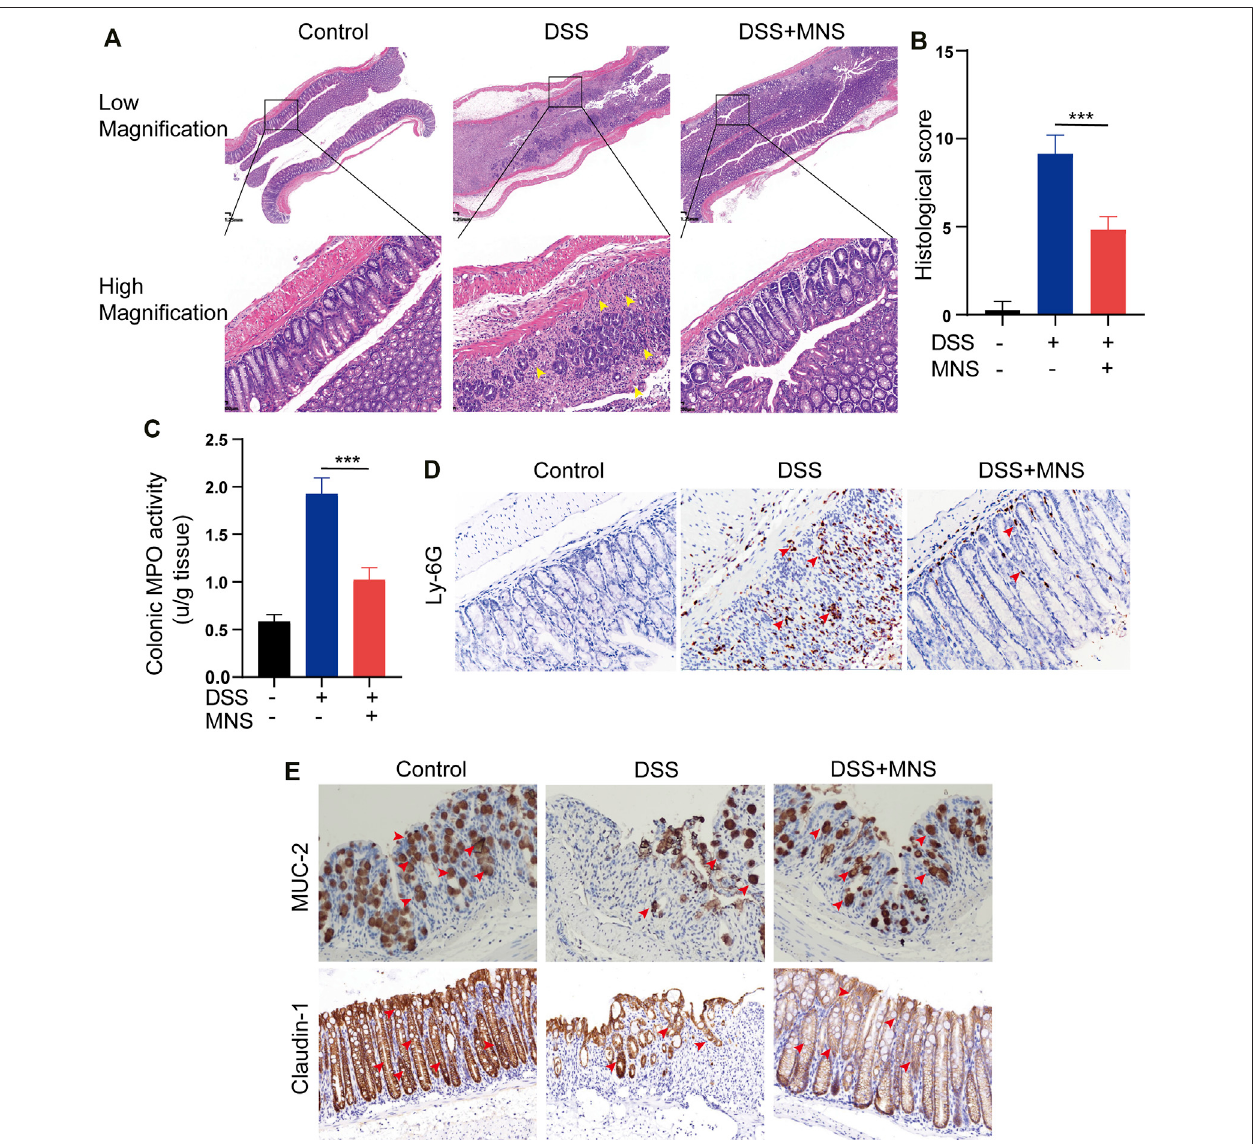
FIGURE 4 | MNS reduced histopathological damage during DSS-induced colitis. (A) Hematoxylin and eosin stain of colon tissue, epithelium loss, and crypt structure collapse were marked with yellow arrows. (B) Histological scores of blinded sections. (C) Colon tissue culture supernatants were assayed for MPO. Immunohistochemistrystainingof (D) Ly-6G (E) MUC-2,andclaudin-1inthecolonweremarkedwithredarrows.N=3mice/group.Datawerepresentedasthemean± standard error of the mean (SEM). *** p < 0.001 vs. the DSS group.